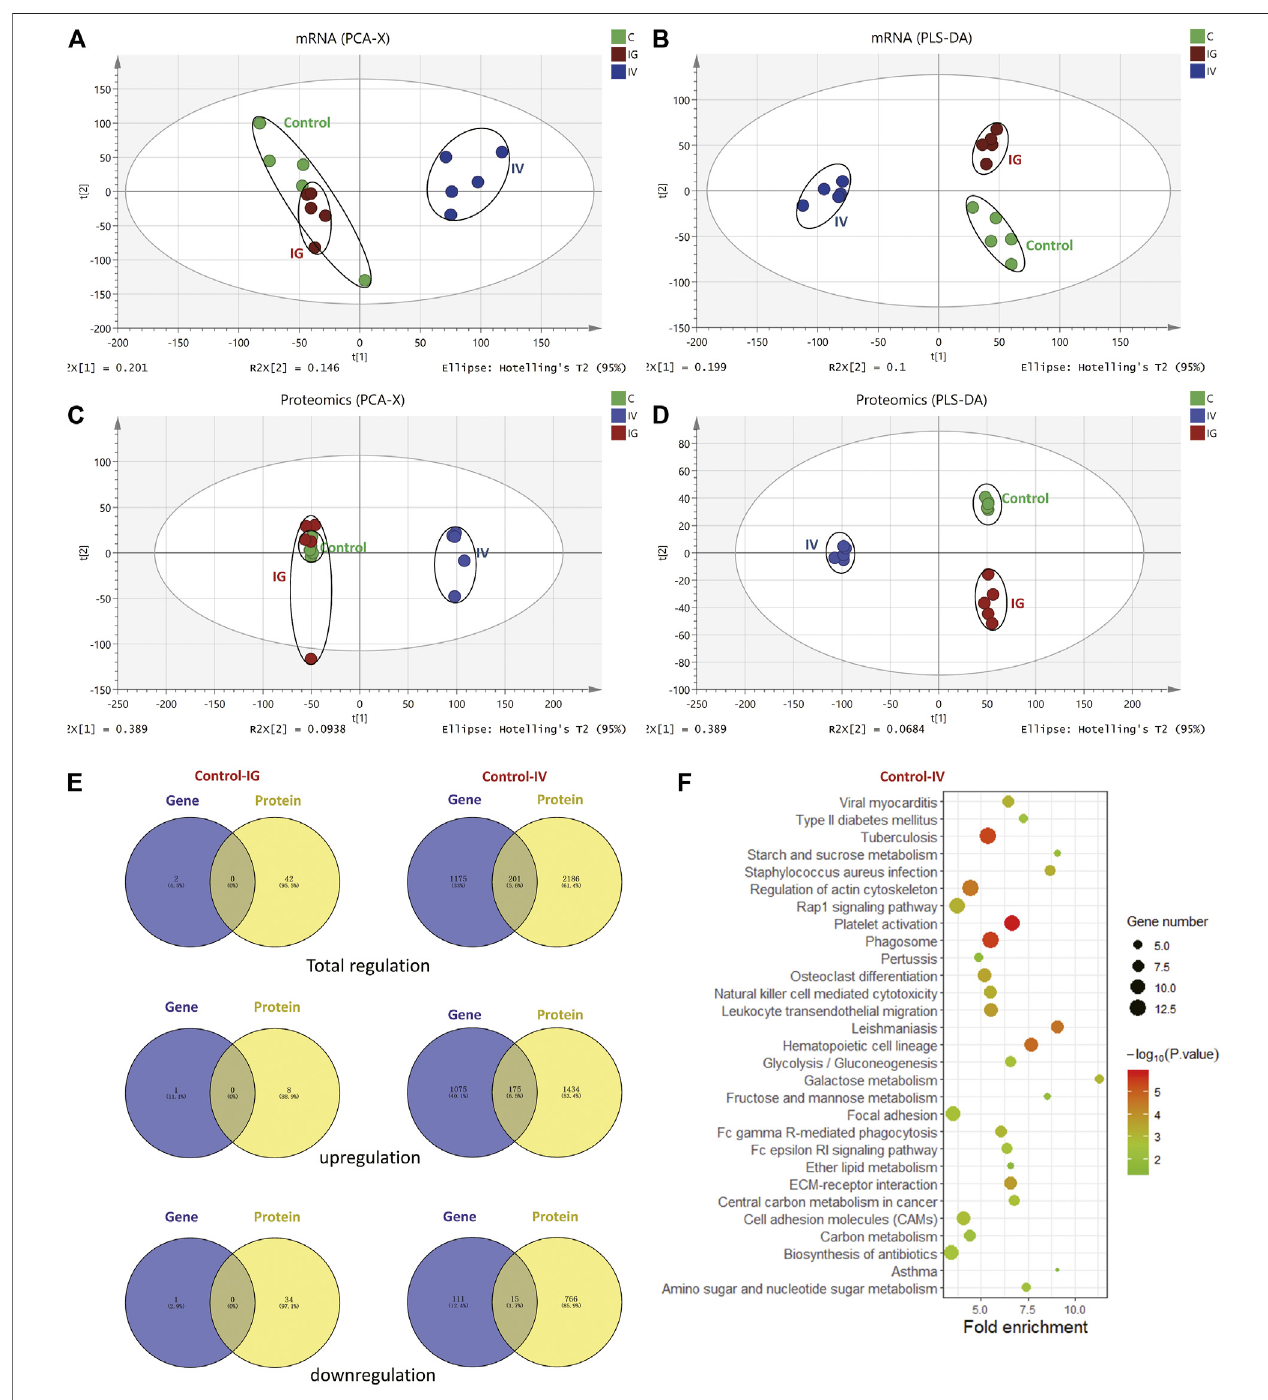
FIGURE 3 | Effect of Mesoporous Silica Nanoparticles (MSNs) administered by different routes (IV and IG) on mouse liver proteins and genes as determined by proteomics and transcriptomics. (A) PCA, (B) PLS-DA of transcriptomics, (C) PCA, (D) PLS-DA of proteomics. (E) Venn diagrams depict overlapping proteomics and transcriptomics data. Theleftpanel showstheregulationofgenesand proteins intheIGgroupcomparedwiththecontrolgroup. Theright panelshows theregulationof genes and proteins in the IV group compared with the control group. (F) KEGG pathway analysis revealed the top 20 pathways based on the same regulation of proteins and genes between the control and IV